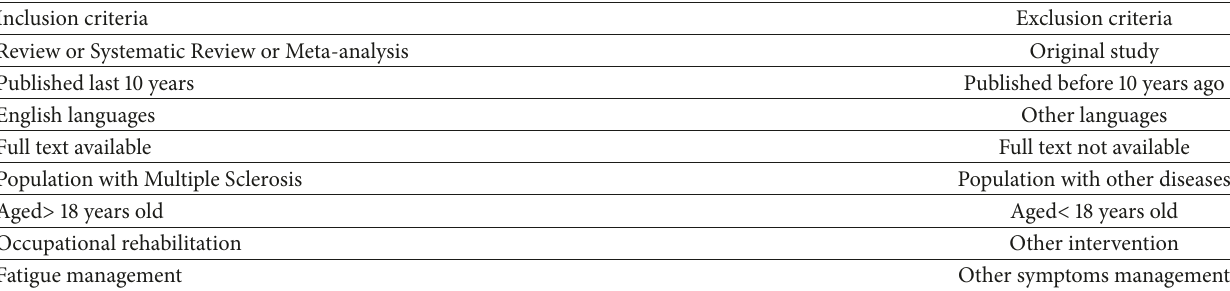
Table 1: Inclusion and exclusion criteria used for paper